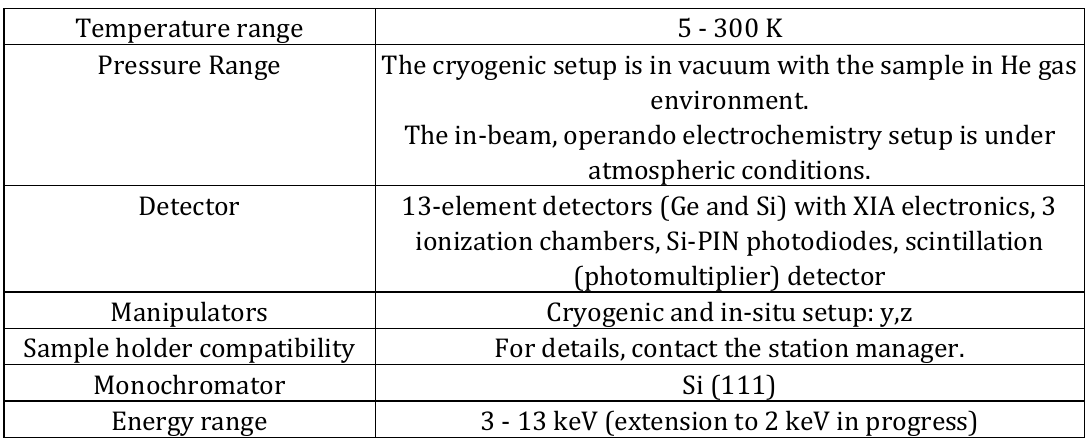
Table 1: Specification of the